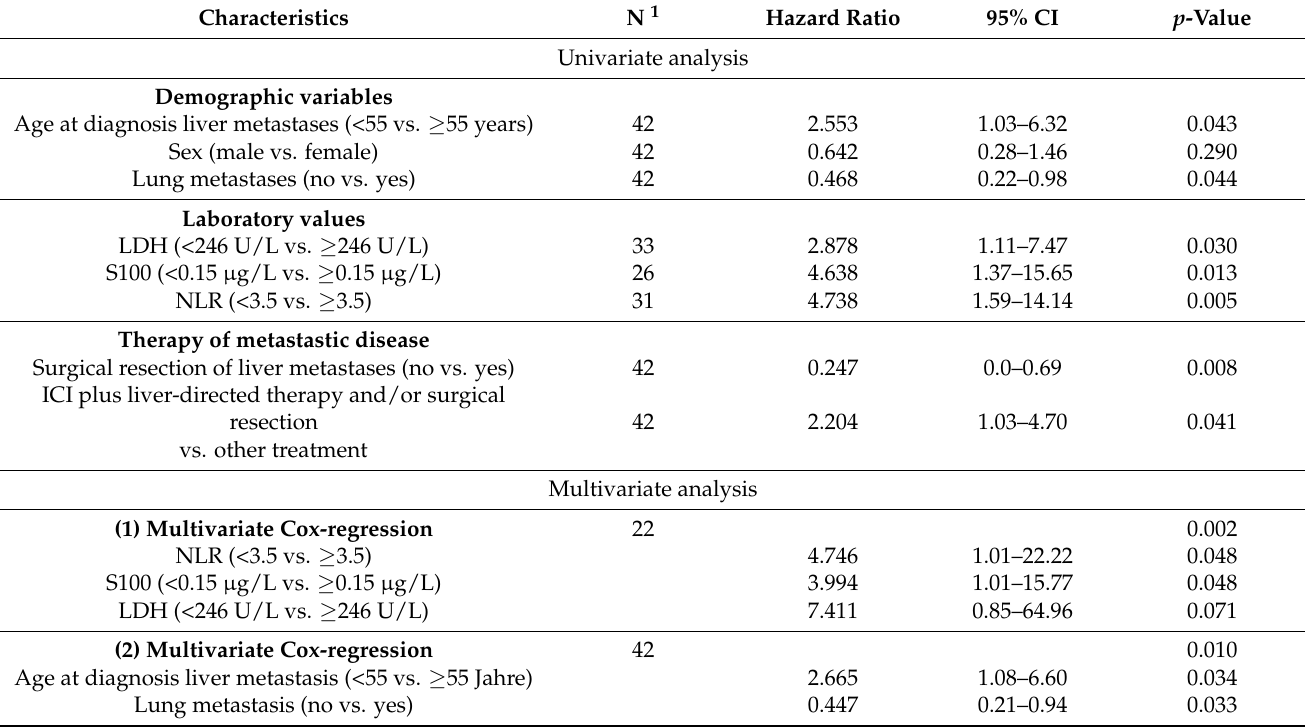
Figure 3. Kaplan–Meier estimates for overall survival (OS) from liver metastasis to death according to therapy, considering the impact of surgical resection of liver metastases. ( A ) Surgical resection of liver metastases indicated a highly significant impact on OS of patients with MUM. ( B ) In order to avoid corresponding bias, comparison of survival between Cohort 1 and Cohort 2 were additionally performed only for those whose metastases were not surgically resected ( n = 31), referred to as Cohort 1.1 (ICI plus liver-directed therapy exclusive surgical treatment) and Cohort 1.2 (monotherapies, combinations of systemic therapy and liver-directed therapies excluding surgical treatment). Table 2. Cox regression analysis (univariate analysis and multivariate